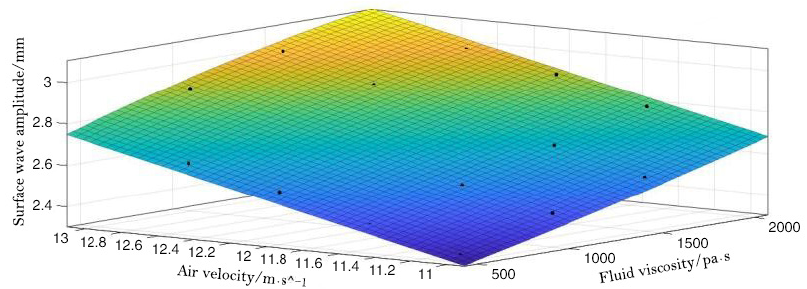
Figure 12. Fitting points and the fitting surface between gas jet velocity, dimethyl silicone oil viscosity